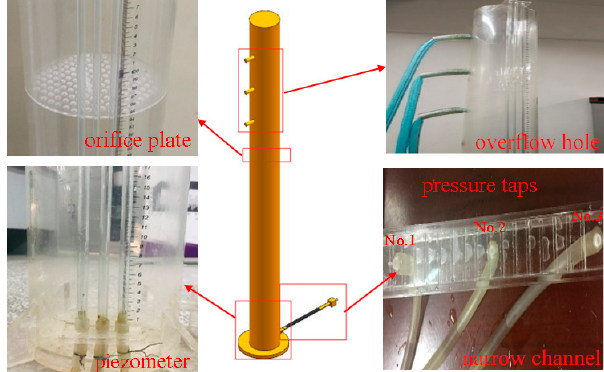
Figure 2. Schematic diagram of the narrow channel experimental device. Energies 2020 , 13 , x FOR PEER REVIEW